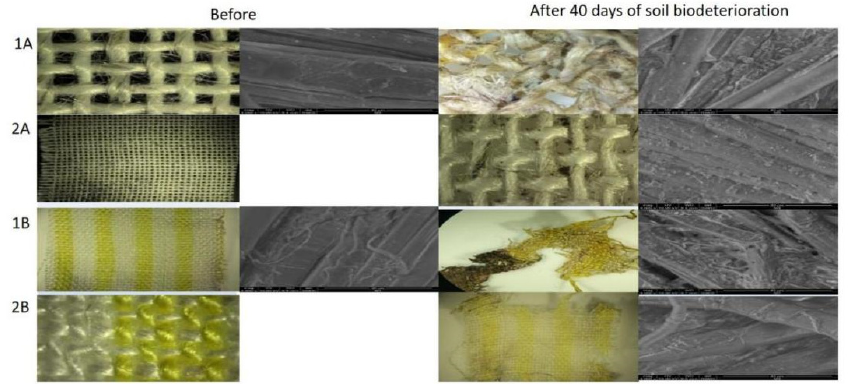
Figure 1. Biodeterioration of plant-based products ( A —cotton and B —linen) in soil #1 from Ceatal- chioi and soil #2 from Bididia-Mineri. Material morphology changes were observed using stereomi- croscope (right images) and scanning electron microscopy (2000 × /4000 × ) (left images).